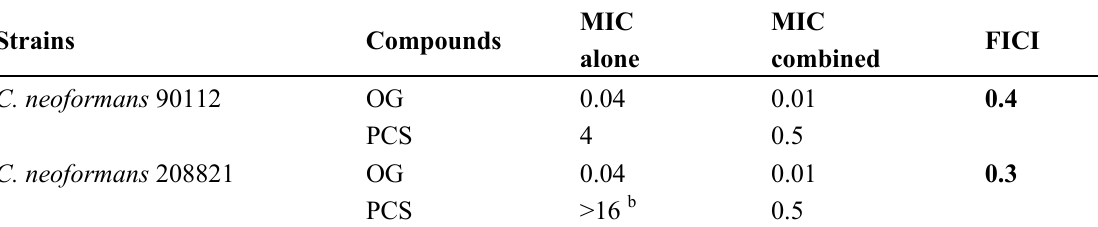
Table 7. Antifungal chemosensitization of OG (mM) to PCS ( μ g/mL) tested against Cryptococcus strains: EUCAST-based microdilution bioassays. a